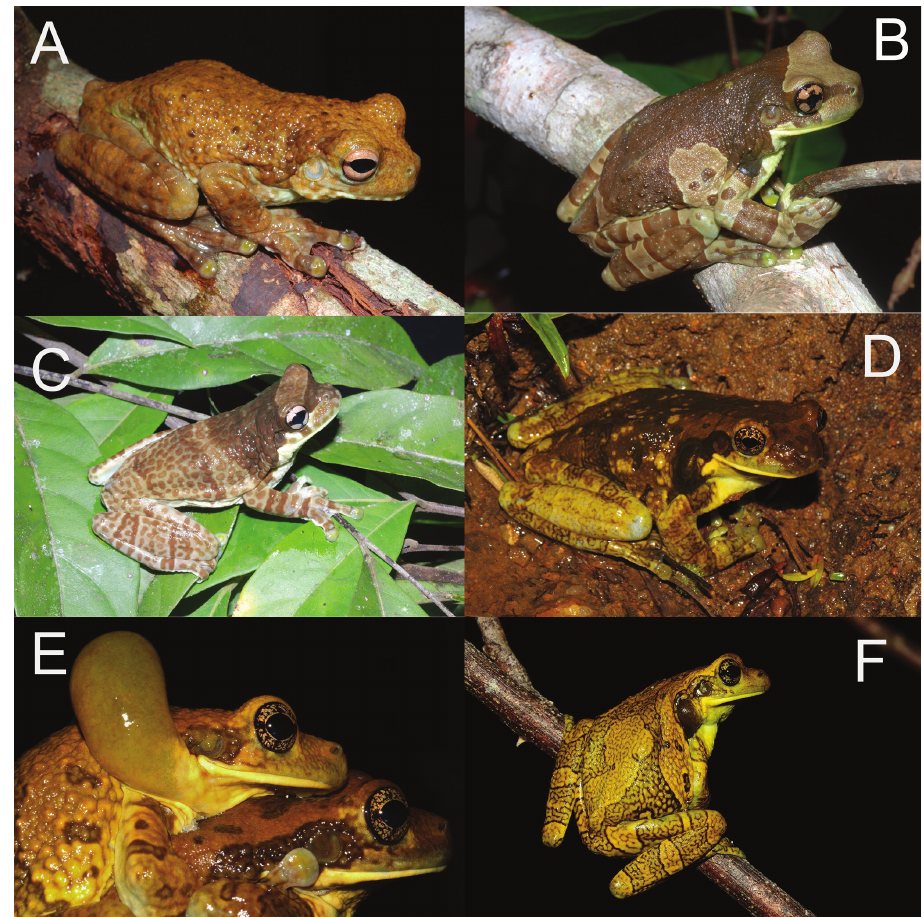
Figure 8. Dorsolateral views of Amazonian Trachycephalus . A Trachycephalus helioi , Juruti, Pará, Brazil B Trachycephalus resinifictrix , Juruti, Pará, Brazil C Trachycephalus cunauaru , Santa Izabel do Rio Negro, Amazonas, Brazil D–E Trachycephalus typhonius , Village de Ouanary, French Guiana F Trachycephalus typhonius , Matiti, French Guiana. Photographs: A–C by M. Gordo, D–E by Daniel Baudain, F by Vincent